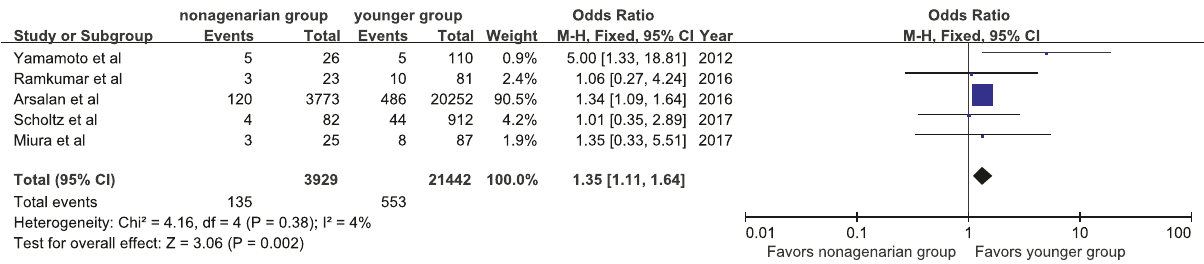
Figure 7: Forest plot of pooled analysis comparing the rates of vascular complication in nonagenarians versus younger patients.